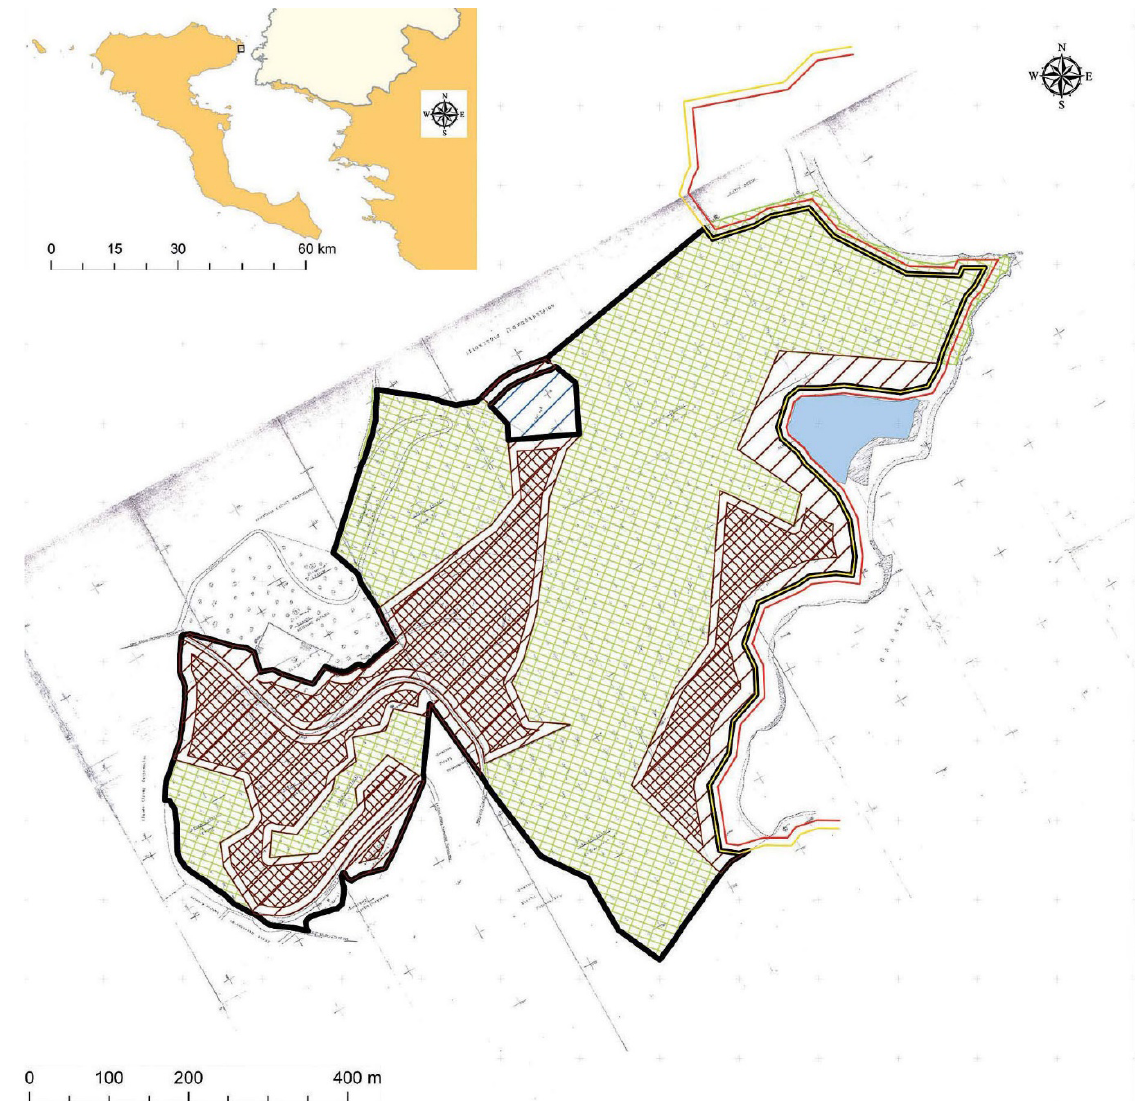
Figure 2. Special Spatial Development Plan for Kassiopi, Corfu, showing the boundaries of the estate, the development zones and the protected areas. Source: Hellenic Republic